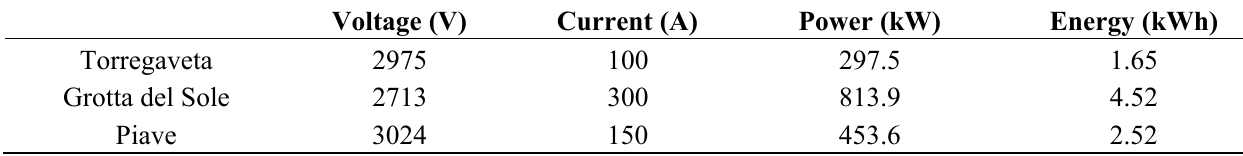
Table 4. Powers and energy supplied by EDLCs in the